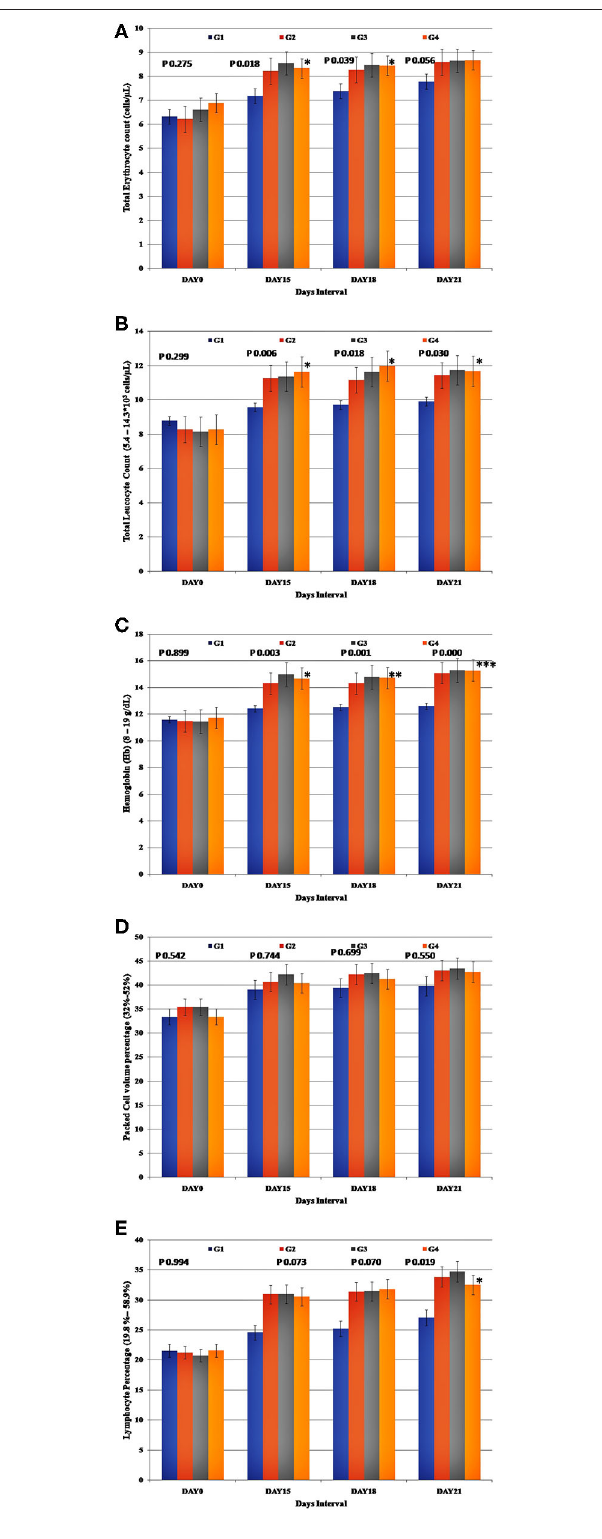
FIGURE 2 | Presentation of the hematological parameters recorded for each study group. (A) Group-specific total Erythrocyte count (TEC), (B) total Leucocyte count (TLC), (C) estimated Hemoglobin (Hb), (D) Packed Cell Volume, and (E) Lymphocyte